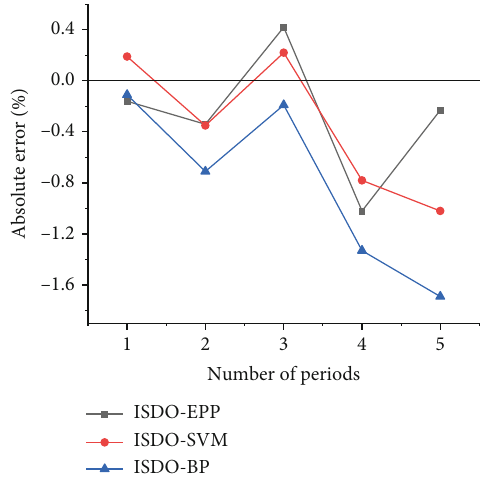
Figure 3: Absolute error of three models in example 2.